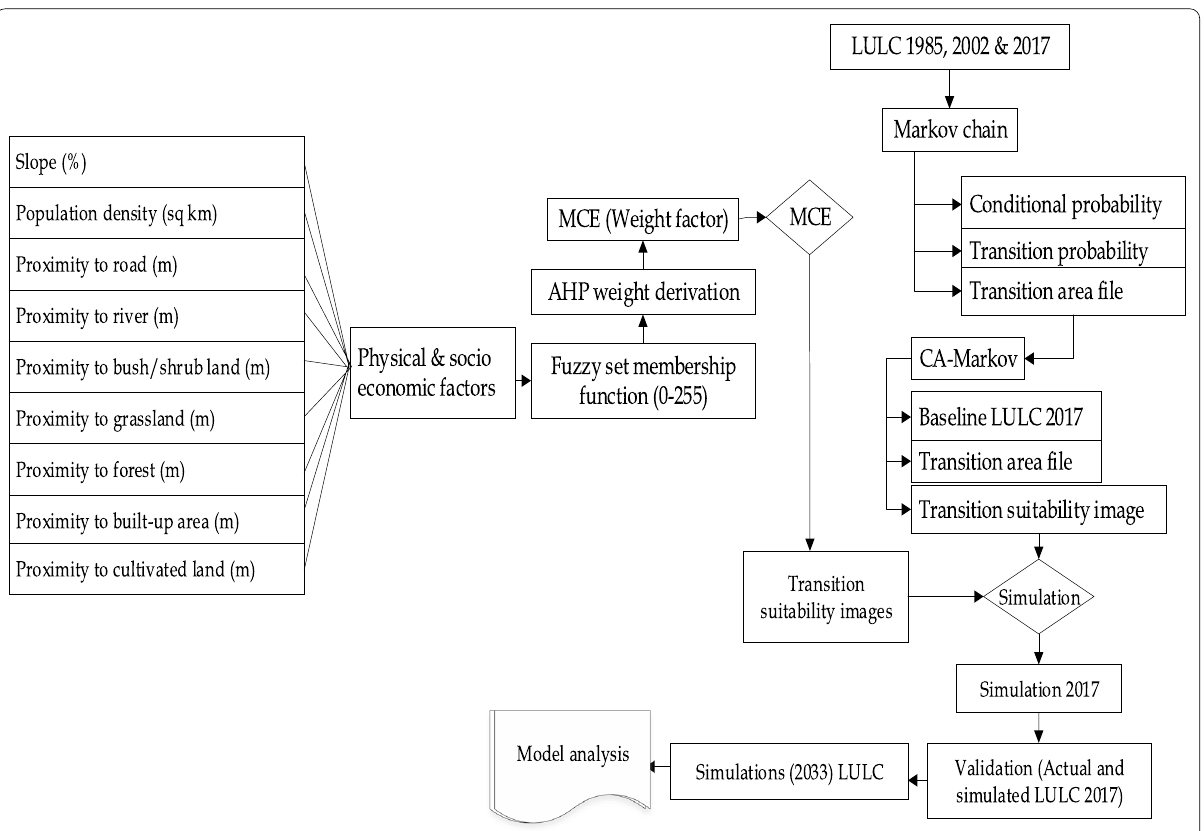
Fig. 2 Schematic diagram for simulating the future LULC using CA–Markov chain